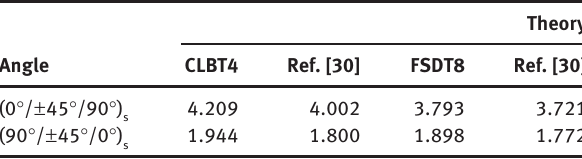
Table 5 Comparison of non-dimensionalized natural frequencies of a cantilever symmetric angle-ply composite beam with material II = 25; L / h = / E ( E 1 2